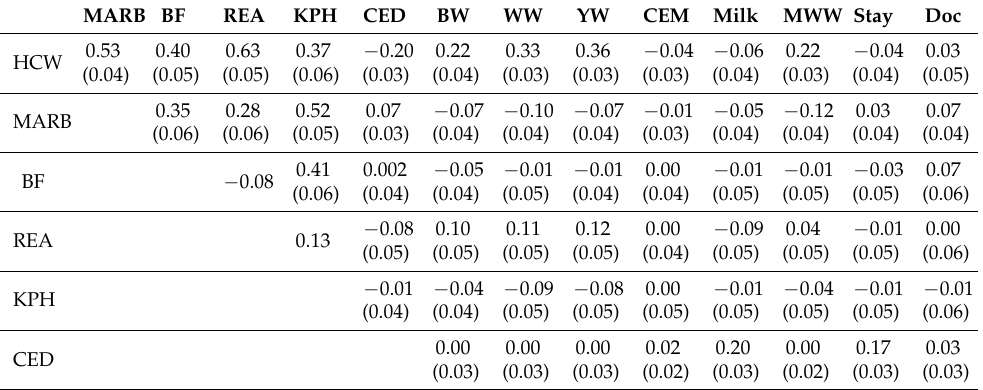
Table 2. Genetic correlations and standard errors between carcass and maternal traits 1 .